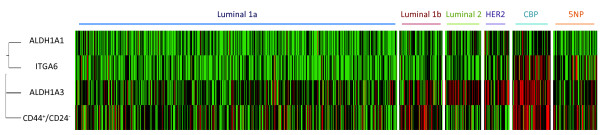
Heatmap of CSC marker expression across breast cancer molecular subtypes. Heatmap illustrating the unclustered distribution of cases from a single randomly selected imputed dataset across molecular subtypes defined by a five-marker IHC classifier. CSC markers arranged by average linkage clustering.